Question: Compose a caption that would accompany this figure in a paper.
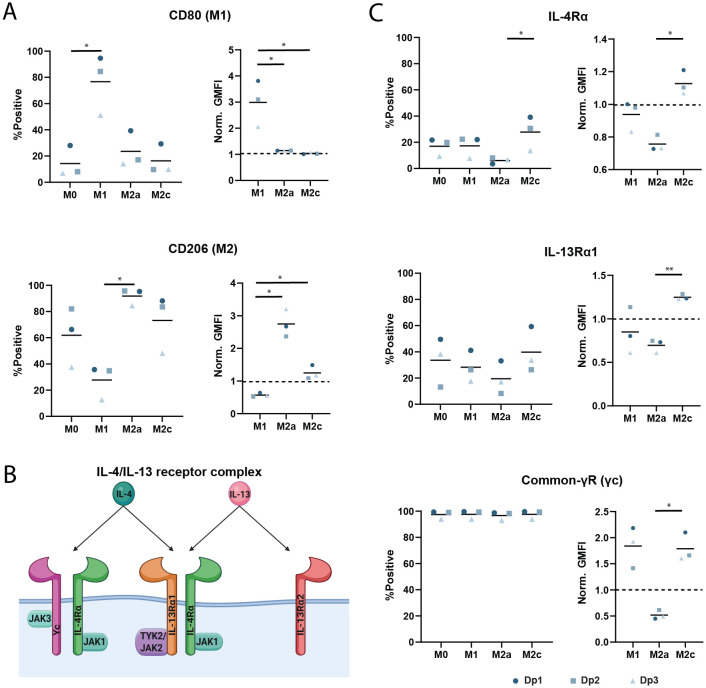
Answer: Macrophage polarization confirmation and interleukin-4 (IL-4)/IL-13 receptor complex expression measurement. (A) Polarization status of macrophages before initiating fusion (Day 0) was determined using cluster of differentiation 80 (CD80; M1) and CD206 (M2a). (B) Schematic of IL-4/IL-13 receptor complex; adapted from Nguyen et al., 2020 ( 53 ). Created in BioRender. Conner, T. (2026) https://BioRender.com/4h8j8pa . (C) Flow cytometry measurement of the three functionally active units of the IL-4/IL-13 receptor complex. Flow cytometry data shows the percentage of cells positive for the tested proteins and the geometric mean fluorescence intensity (GMFI) normalized to M0, for 3 donor pools (Dp1-3; n=3 biological replicates).